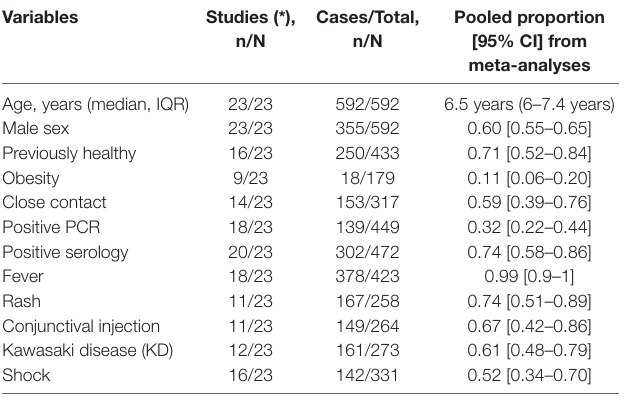
TABLE 2 | Clinical characteristics, laboratory features, and use of resources: meta-analyses. Variables Studies (*),